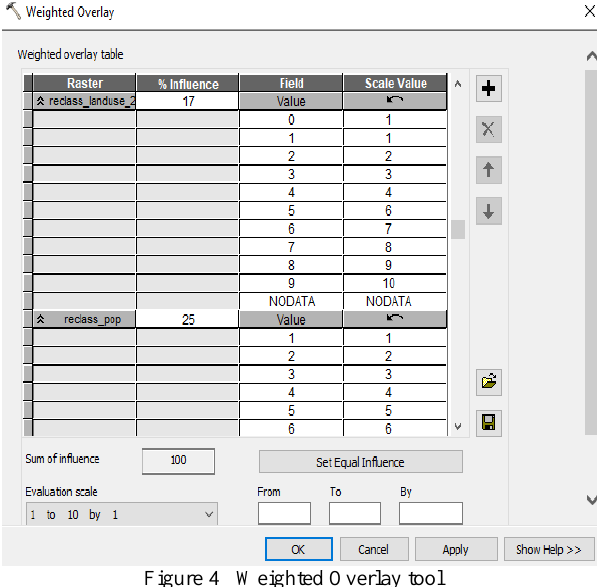
Figure 4 Weighted Overlay